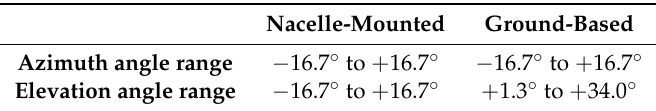
Table 1. Ranges of the azimuth and elevation angles needed to cover the whole volume of interest for both lidar